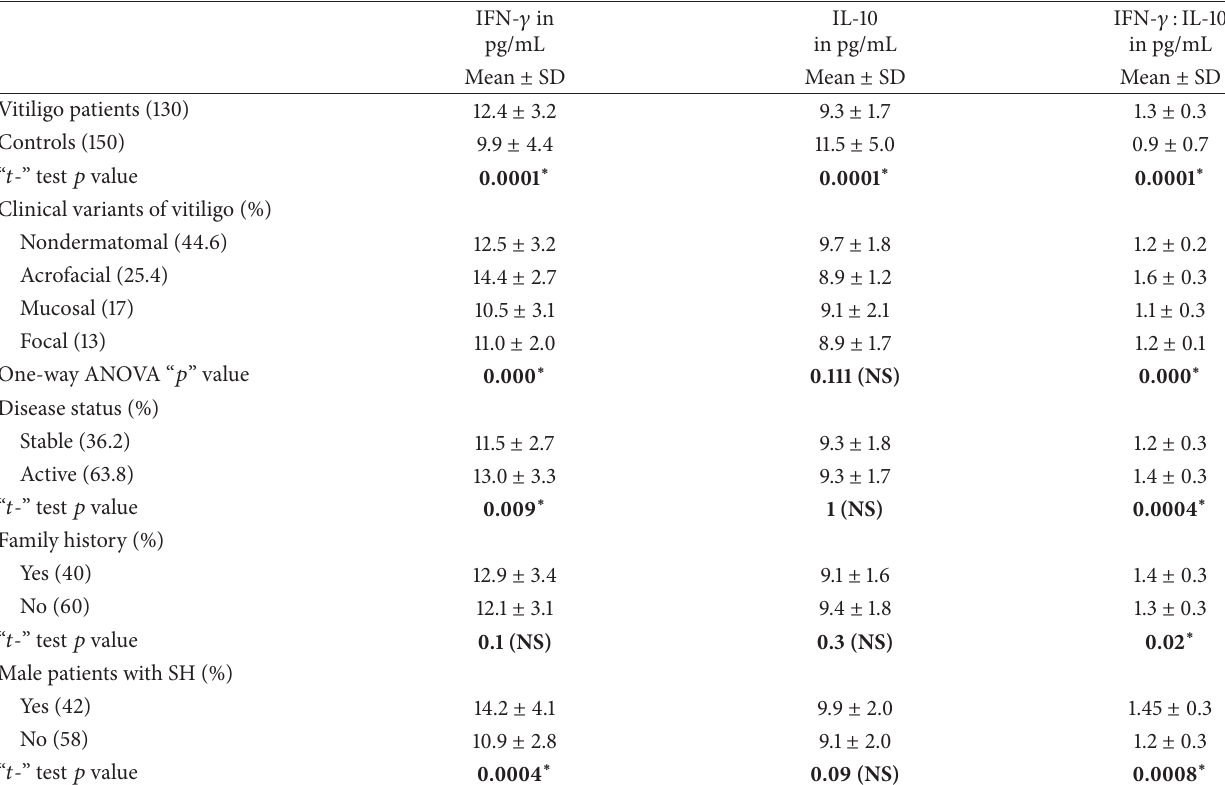
Table 2: Serum concentrations of IFN- 𝛾 , IL-10, and IFN- 𝛾 :IL-10 ratio in controls and vitiligo